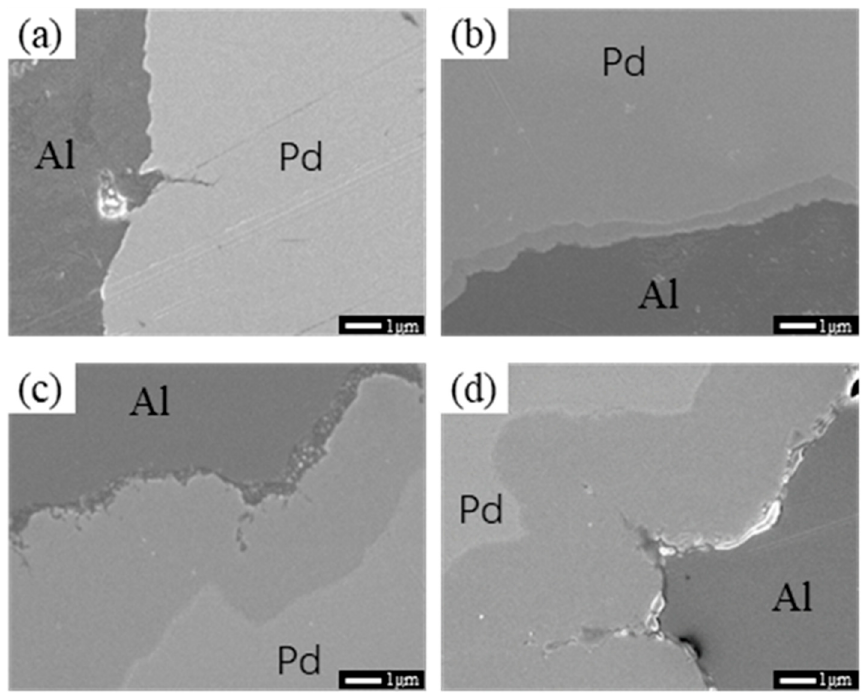
Figure 2. SEM images of Pd/Al composite wires annealed at 200 °C for different times; ( a ) 5 s, ( b ) 60 s, ( c ) 7200 s, and ( d ) 10,800 s.